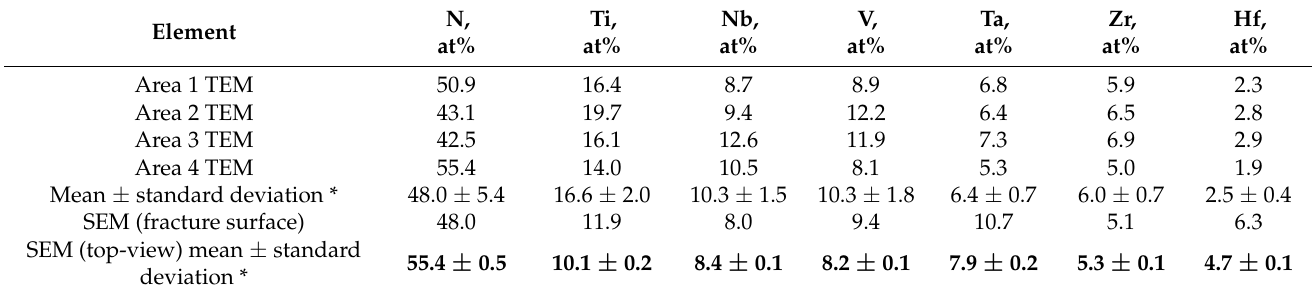
Table 4. Local and average concentrations of each element in HT-6TM-6N coating obtained by EDS in three measurement configurations: on TEM foil, on fracture surface in SEM, and in the top view from four large areas (900 × 680 µm 2 ) in SEM.